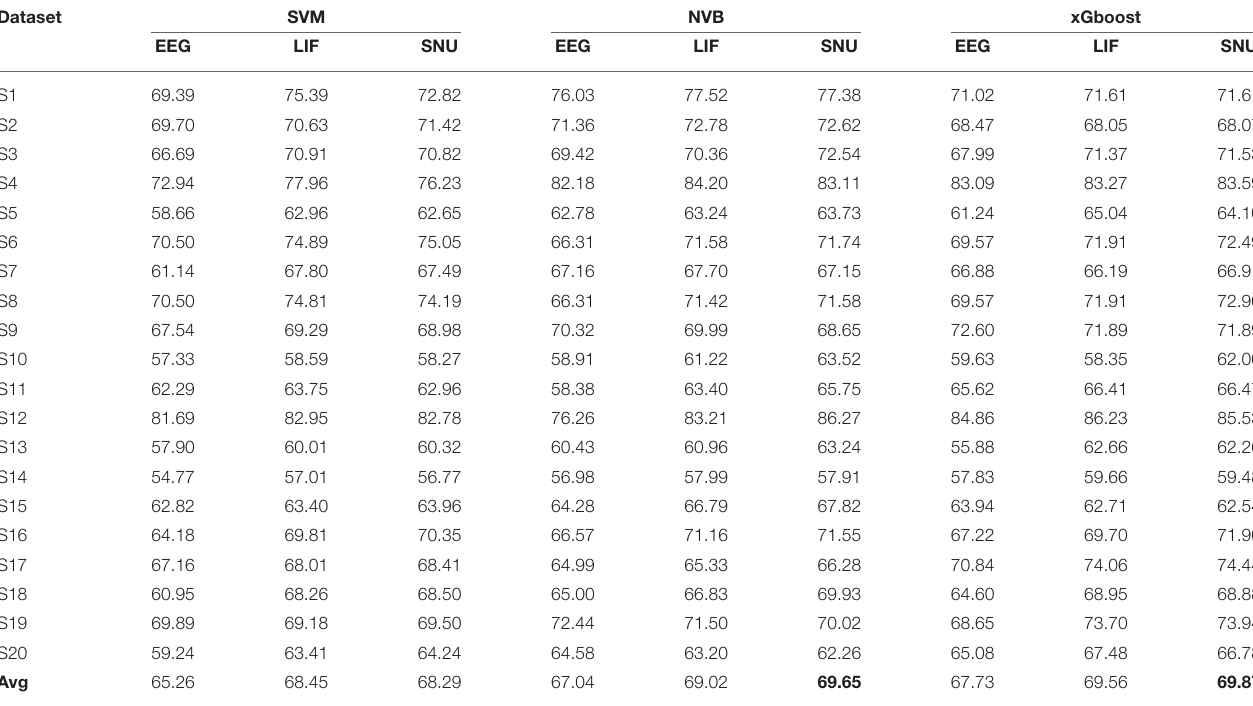
TABLE 2 | Comparison of classification performance of P300 based EEG signal and its spike-representation by LIF-based and SNU-based SNN using SVM, NVB, and xGboost classifiers.